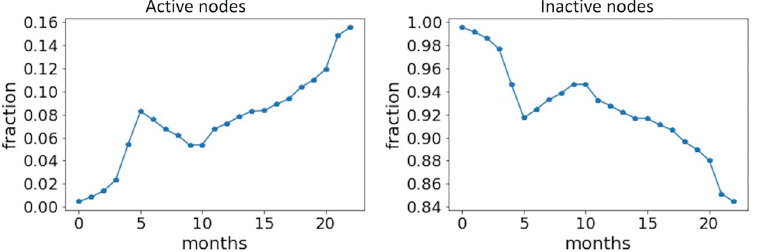
Fig 5. The monthly fraction of active and inactive nodes over the total number of nodes in the given month for the second (stable) period. It can be seen that most of the nodes (users) were not active every month.